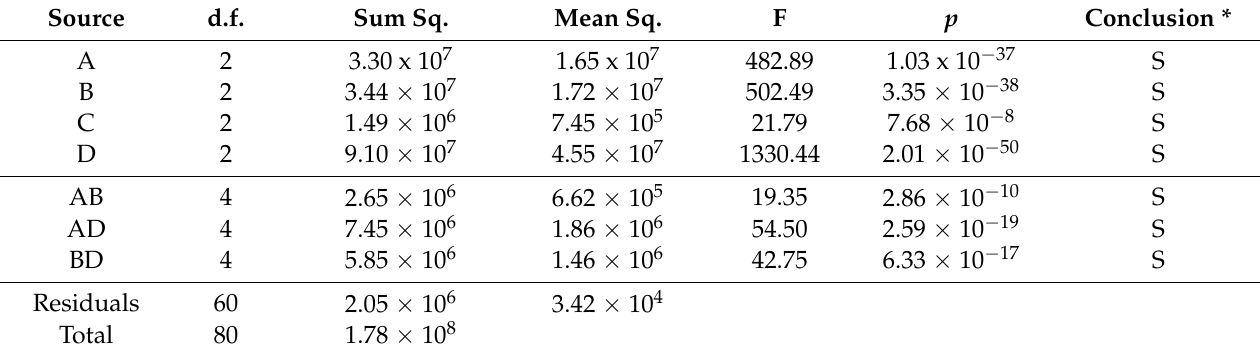
Table 8. Modulus of elasticity results for the reduced model four-factor